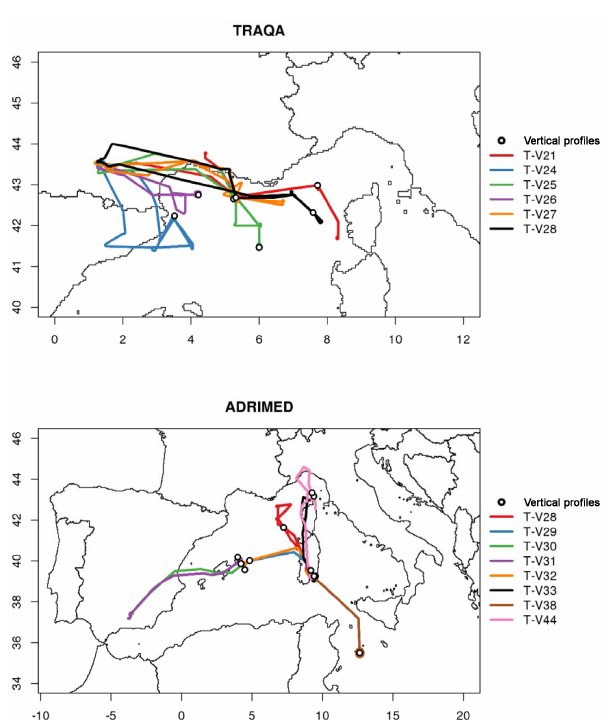
Figure 2. Flight tracks of the ATR-42 aircraft (coloured lines) dur- ing the TRAQA and ADRIMED campaigns. Only flights relevant to this study are presented. The location of the profiles are coincidental at their lowermost altitude, with a POLDER-3 overpass shown by a circle. During the TRAQA campaigns, 7 profiles were retained for comparison on 6 flights. During the ADRIMED campaign, 12 pro- files occurring during 9 flights were retained. In this second case, symbols are not always visible due to